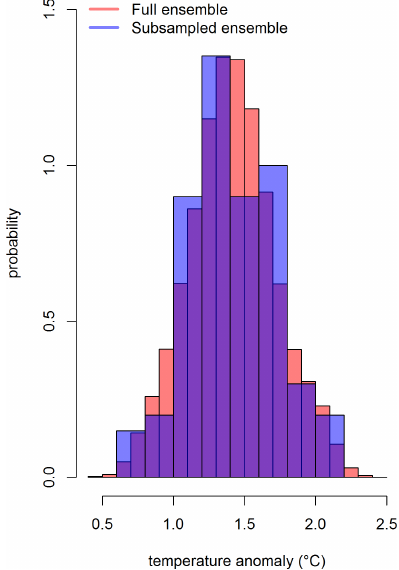
Figure C2. Distribution of the grid box (long and lat are 72 . 5 ◦ and 32 . 5 ◦ , respectively) that includes Lahore for February 1988. The full ensemble consists of 100000 grid boxes (Sect. 4.3), and the subsampled ensemble consists of 100 grid boxes based on Latin hypercube